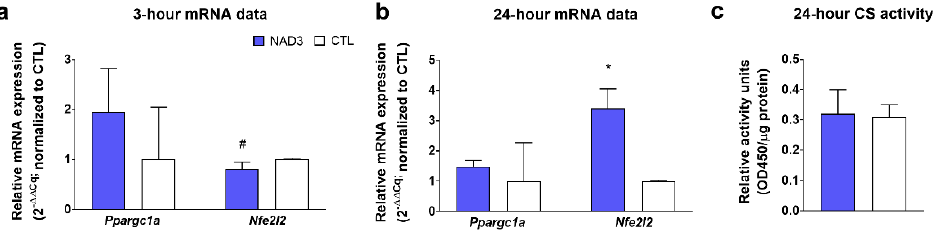
Figure 2. Effects of NAD3 treatments on mitochondrial biogenesis markers. Legend: these data illustrate 3 h treatments on mRNAs related to mitochondrial biogenesis (panel a ), 24 h treatments on mRNAs related to mitochondrial biogenesis (panel b ), and 24 h treatments on a surrogate marker of mitochondrial volume (panel c ). All data are presented as the means ± standard deviation values ( n = 6 treatment wells per condition), and significance was set at p < 0.05. Symbols: *, indicates more highly expressed in NAD3-treated versus control (CTL)-treated cells; #, indicates more highly expressed in control (CTL)-treated versus NAD3-treated cells. Other abbreviation: CS, citrate synthase.